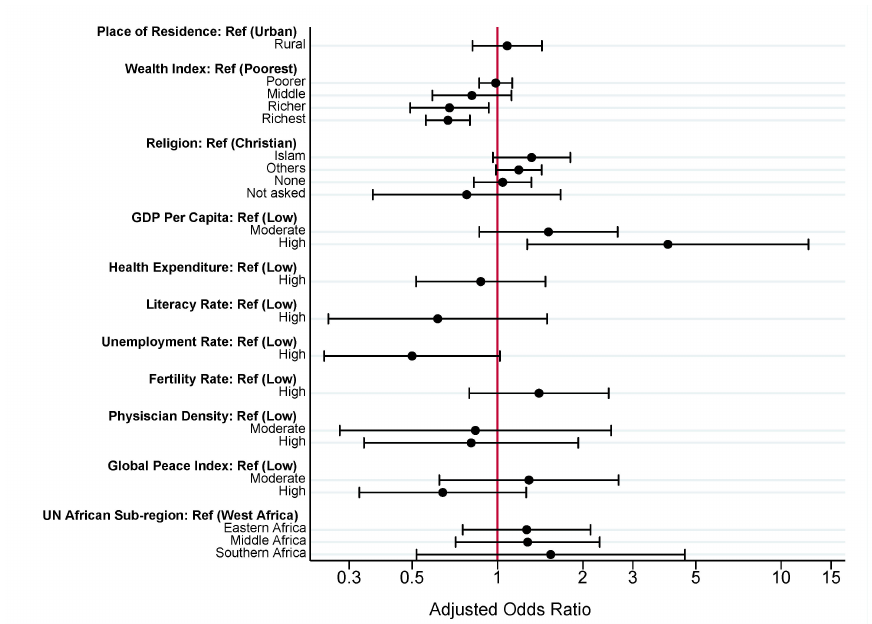
Figure 2. Multi-level analysis of contextual factors associated with zero-dose vaccination status among children aged 12–59 months in SSA. Estimates from Model 4 (Table S1). X-axis presented on natural log